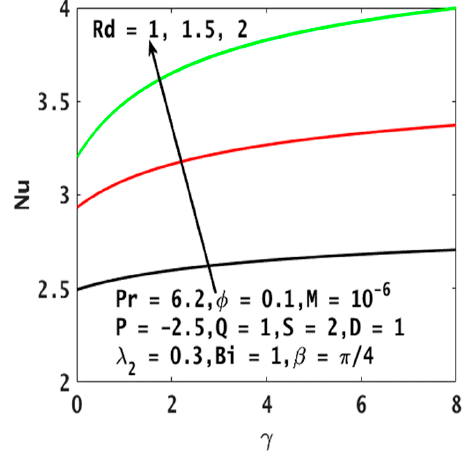
Figure 6. Variation of Nu with φ .